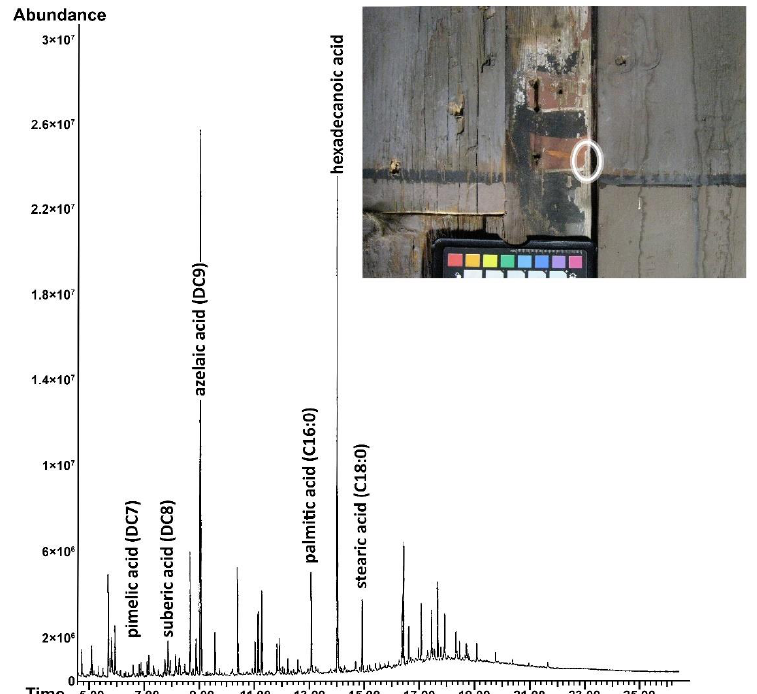
Figure 8. An example of the total ion chromatogram of paint specimen and image of sample location. Total ion chromatogram of paint specimen (E1b) showing characteristic peaks of pine resin around 16–19 min (i.e., abietic acid). Circle within image denotes sample location.